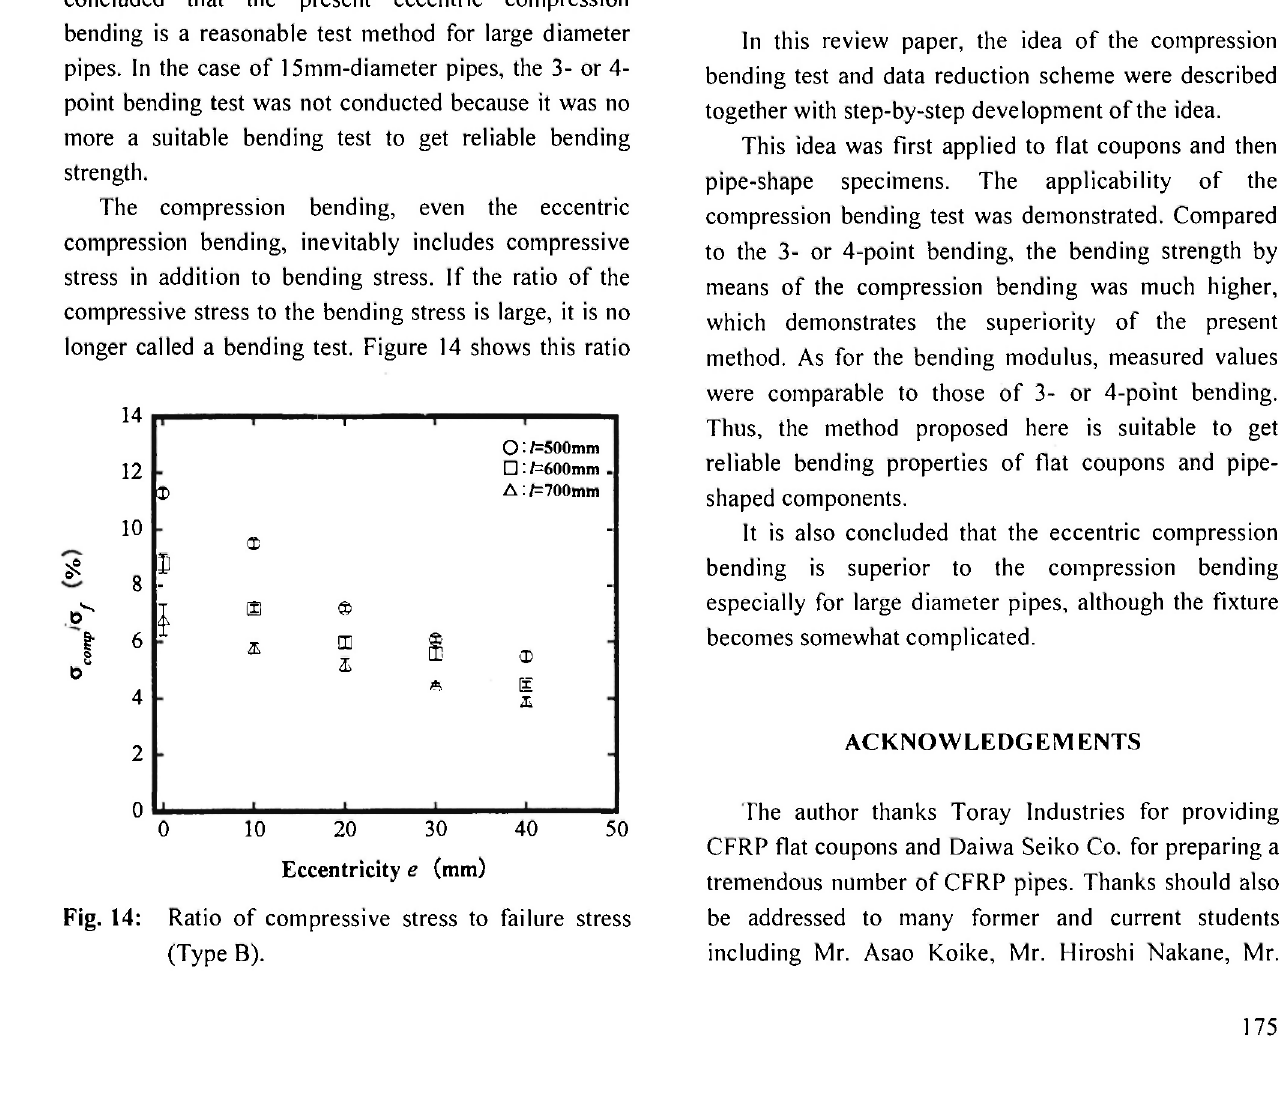
Fig. 13: Failure stress vs. eccentricity (Type B).